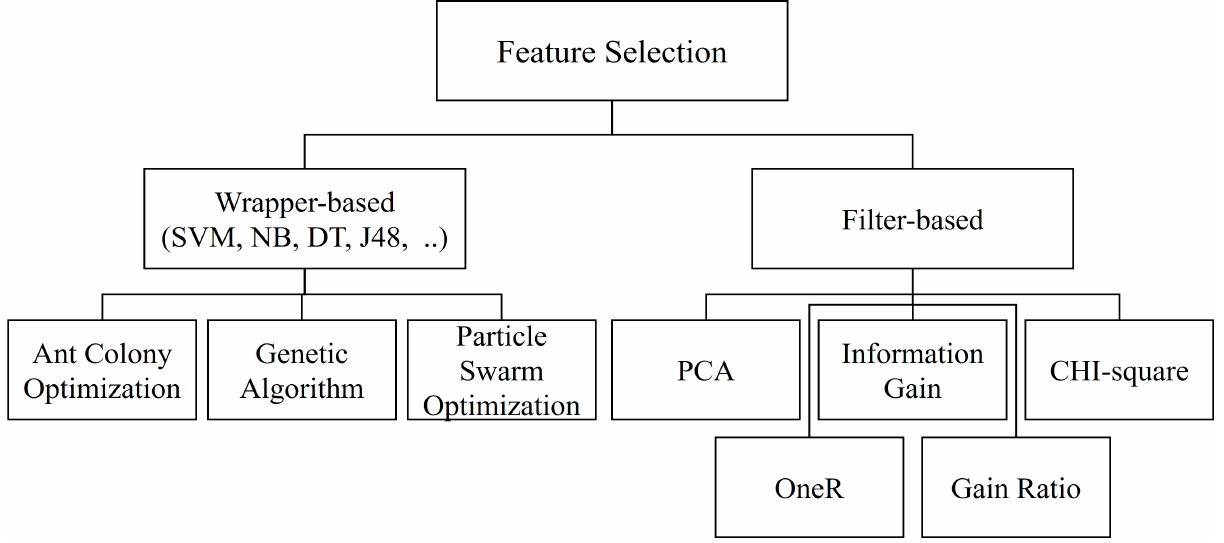
Figure 2. Type of feature selection